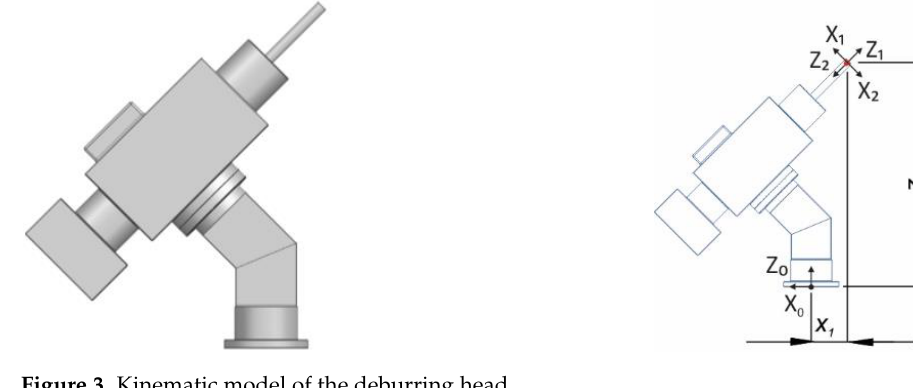
Figure 3. Kinematic model of the deburring head. To include a deburring head in the robot kinematic model, HTMs representing the T robot . 1 T tool were multiplied by 0 T tool is translation and orientation of the spindle frame 2 0 0 6 = [ − 0.075, 0, 0.456 ] , which is the translation vector representing the obtained from t tool 1 = [ 0, − π /4, 0 ] , which are the Euler angles representing the orientation position and r tool 1 T robot . 2 T tool is obtained by of the spindle frame relative to the robot end-effector frame 6 1 = [ 0, 0, π ] to align the orientation of the adding a final rotation by Euler angles r tool 2 spindle frame according to the post-processed toolpath. All the position coordinates are in meters and all the orientation coordinates are in radians. The spindle rotation is